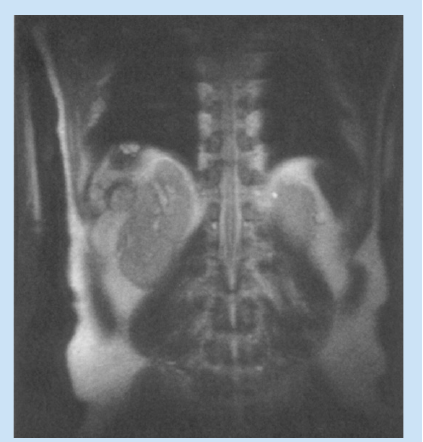
Fig. 3d. MRI confirming multiple smaller cysts in both